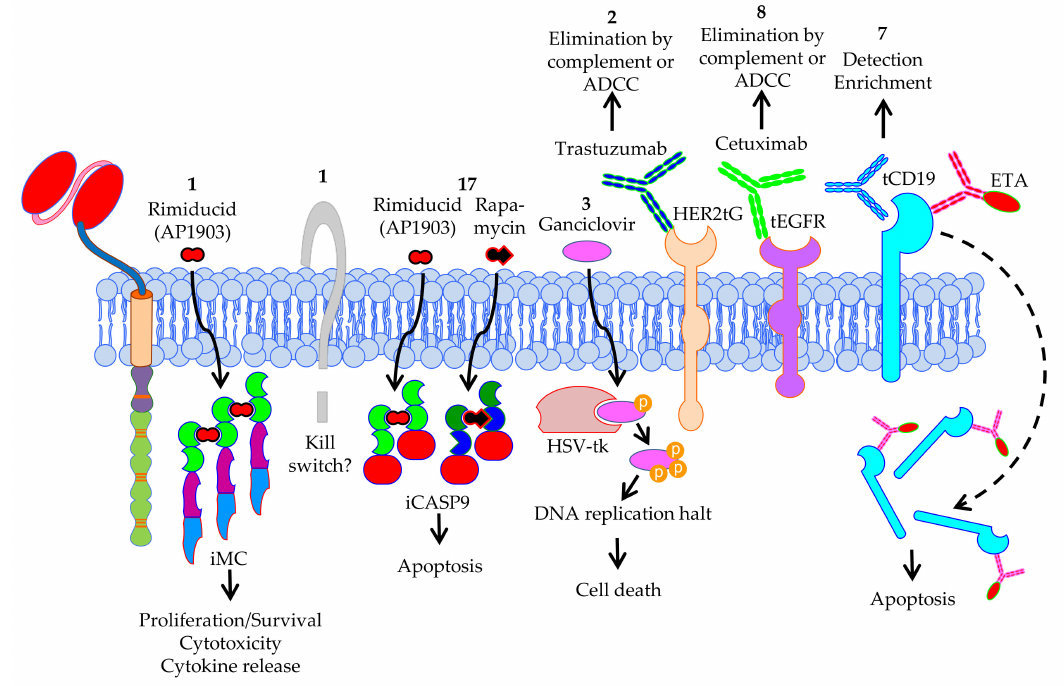
Figure 10. Schematic overview of safety measurements used in the treatment with CAR-T cells against solid tumors. The numbers indicate the number of clinical trials using this safety measurement. Data was extracted from clinicaltrials.gov. The Motifolio Scientific Illustration Toolkit was used for the generation of this